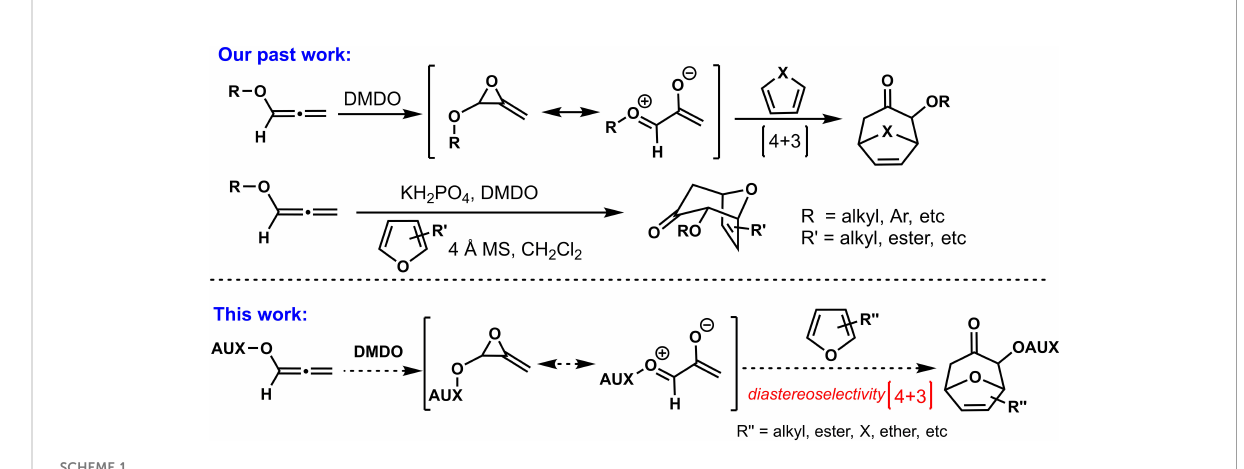
SCHEME 1 Strategies for (4+3)